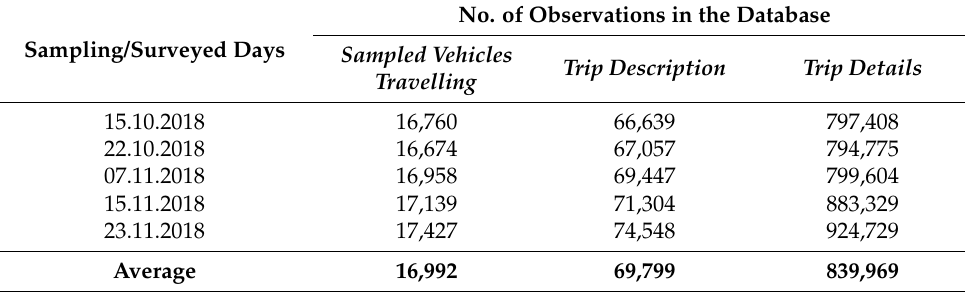
Table 2. FCD/AVM database characteristics.